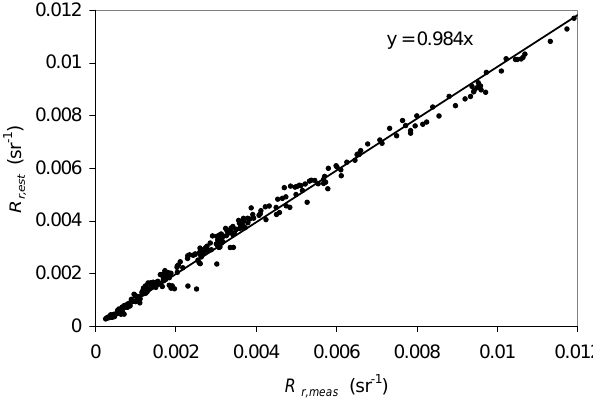
Figure 4. Estimated vs. measured values of the radiance reflectance R r for all data sets and wavelengths.